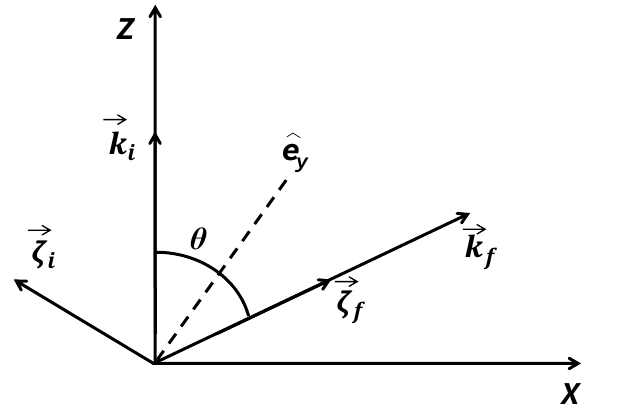
Figure 1. Coordinate system showing the ( x , z ) scattering plane spanned by the lepton momenta (cid:126) k i and (cid:126) k f , the spin polarization vectors (cid:126) ζ i and (cid:126) ζ f , and the scattering angle θ